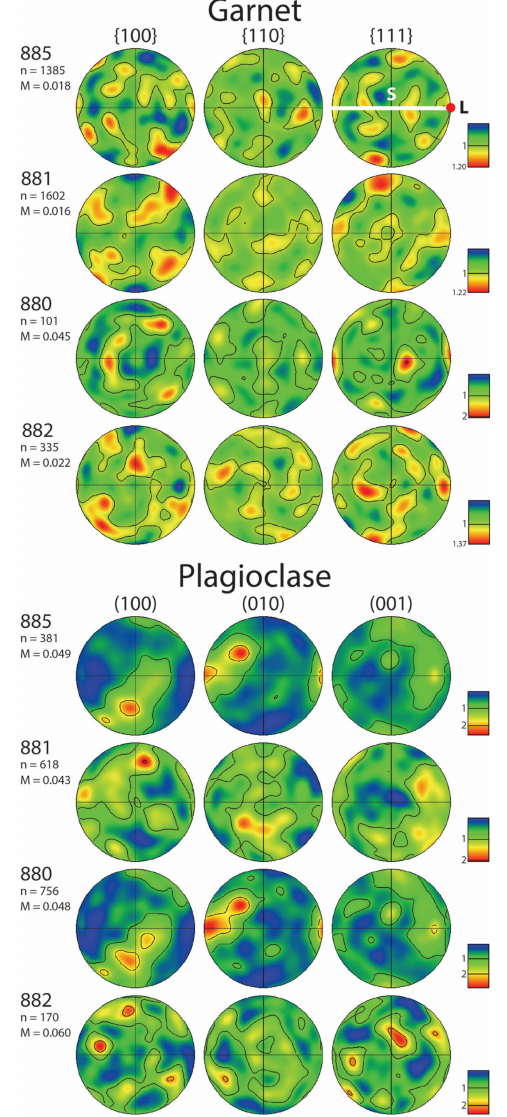
Figure 6. Pole figures (PFs) of garnet and plagioclase. PFs are presented in the lower hemisphere using an equal area projection. S indicates foliation, and L indicates lineation. Fabric strength of the mineral is shown as the M-index (M). A half scatter width of 20 ◦ was used. The color coding refers (different for each sample) to the density of data points (n), and contours are shown in multiples of uniform distribution. n: number of